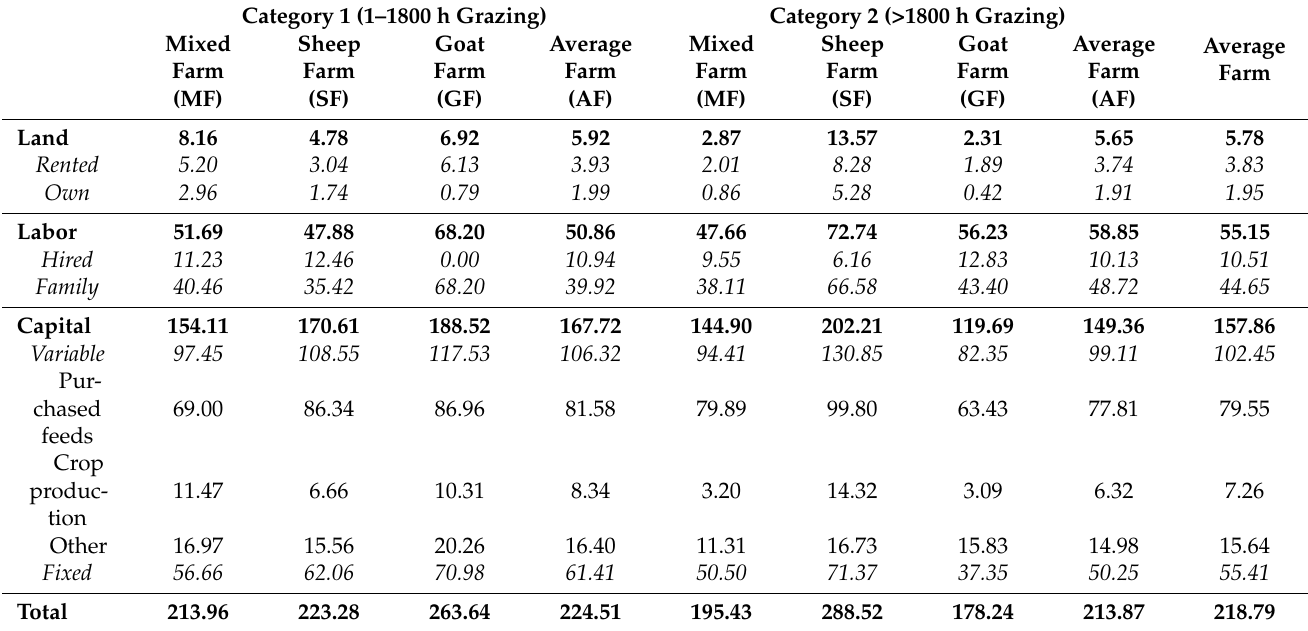
Table 3. Cost structure of the